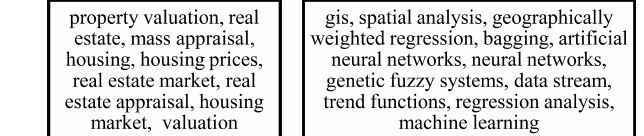
Figure 1. Refined search in Scopus database.